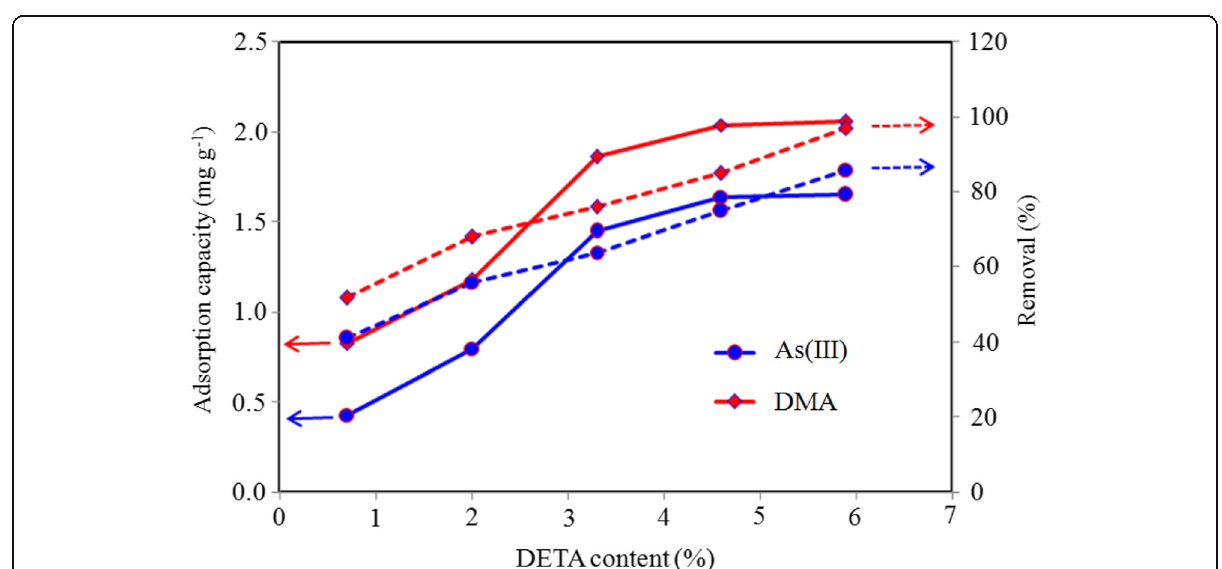
Fig. 4 Effect of grafted amino density on the adsorption